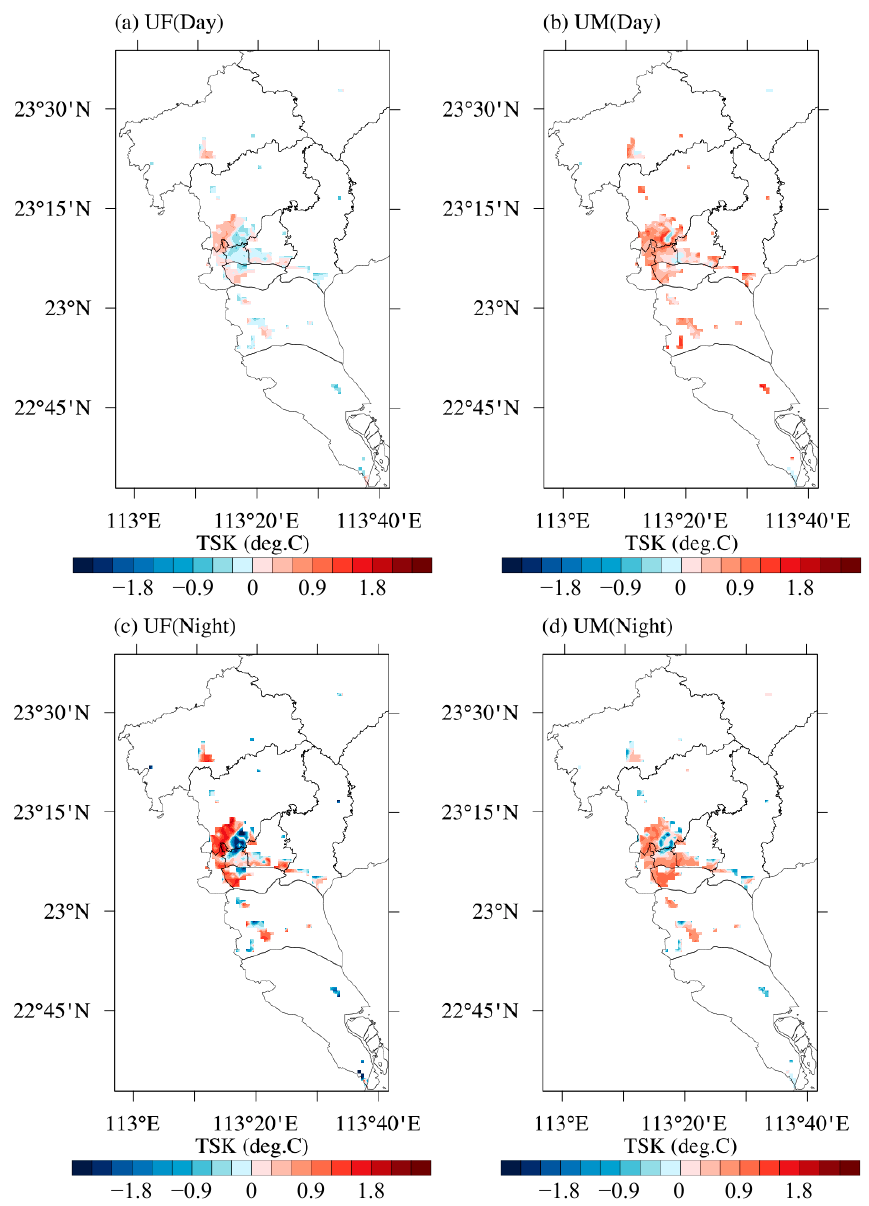
Figure 4. Impact of the high-resolution UF and UM on the daytime and night-time mean surface skin temperature (TSK) in the underlying surface of Guangzhou. Here, the impacts of UF/UM during the daytime were calculated by comparing the simulated hourly TSK values from 08:00 LST to 16:00 LST for 10 days (from 1 to 10 November) in two experiments and then averaging the result. meanwhile, those during night-time were derived using the data from 17:00 LST to 07:00 LST. ( a , c ) Effect of UF (Case 1–Base); ( b , d ) effect of UM (Case